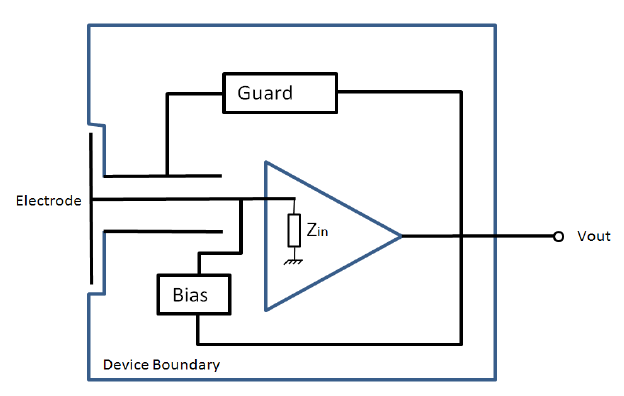
Figure 3. Charge amplifier